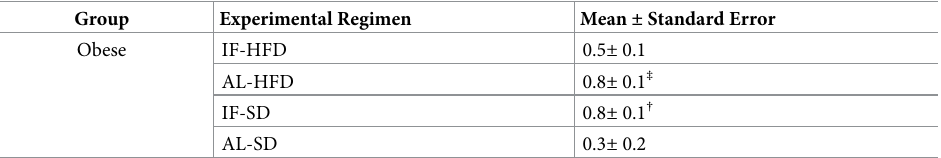
Table 4. Blood ketone levels in obese